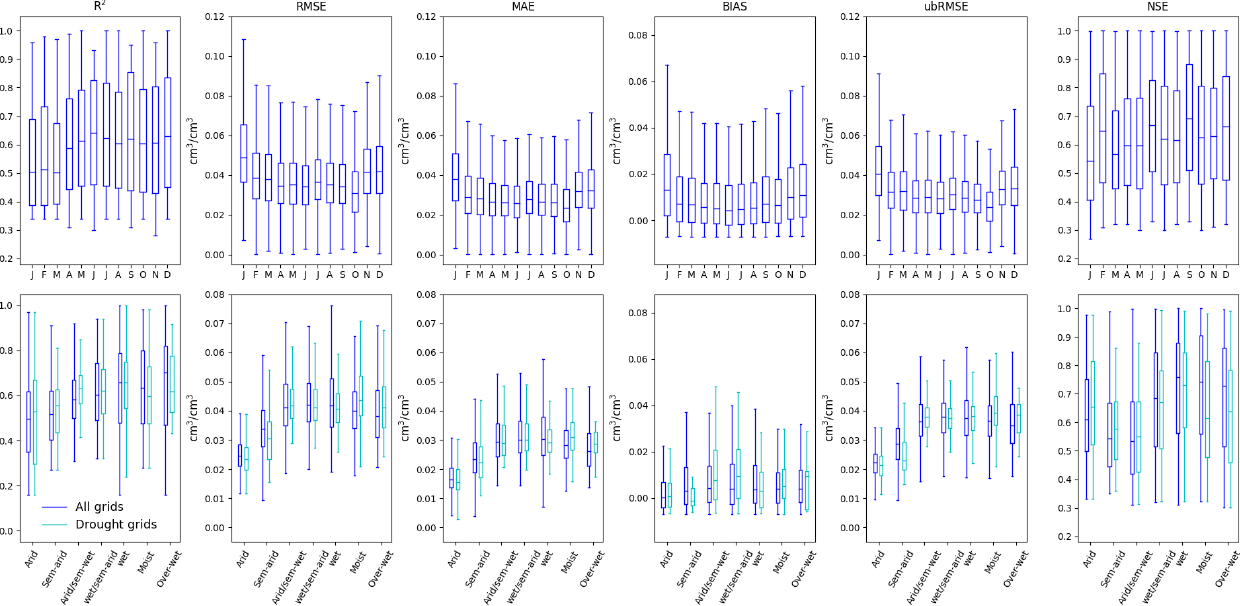
Figure 8. Accuracy metrics of 10 cross-validations for R 2 , RMSE, MAE, BIAS, ubRMSE, and NSE: panel (a) is averagely obtained on a monthly basis, and panel (b) is averagely obtained for each climate region and for the drought grids.